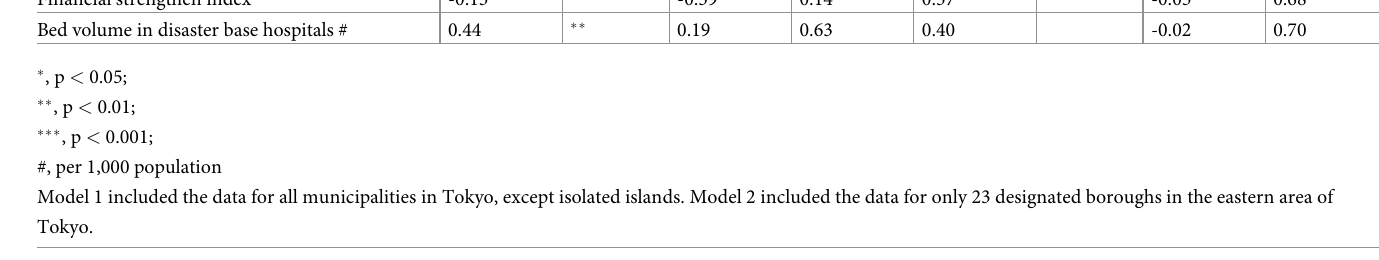
Financial strengthen